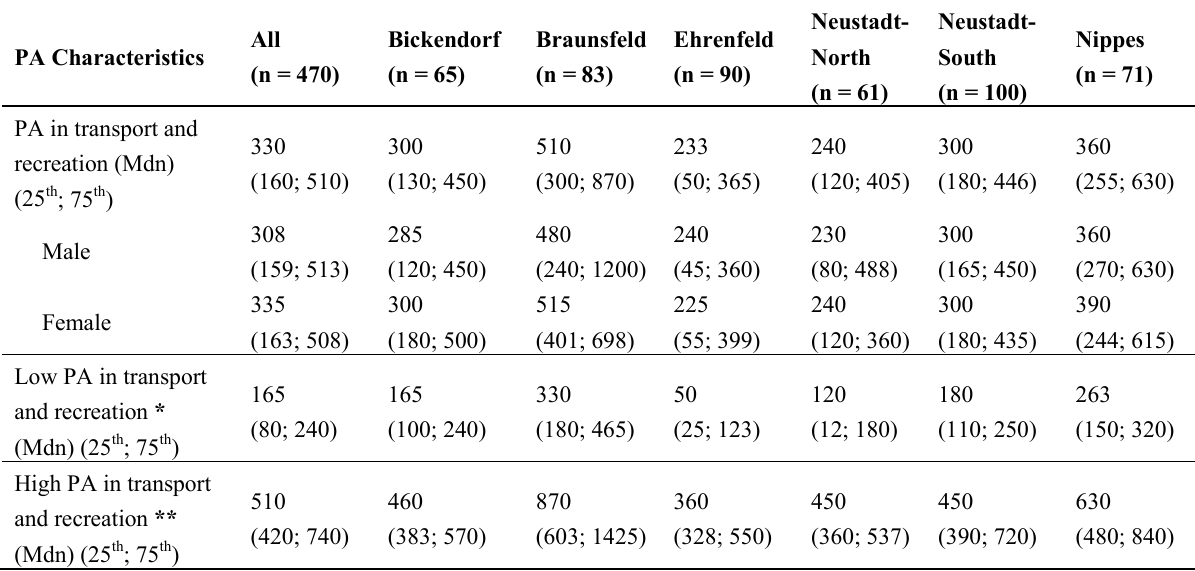
Table 3. PA in transport and recreation (MET min × week -1 ) of the overall sample and of the subsample in selected city districts.